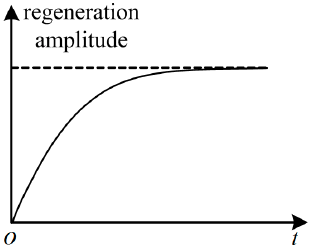
Figure 5. The assumed relationship between rest time and regeneration amplitude.